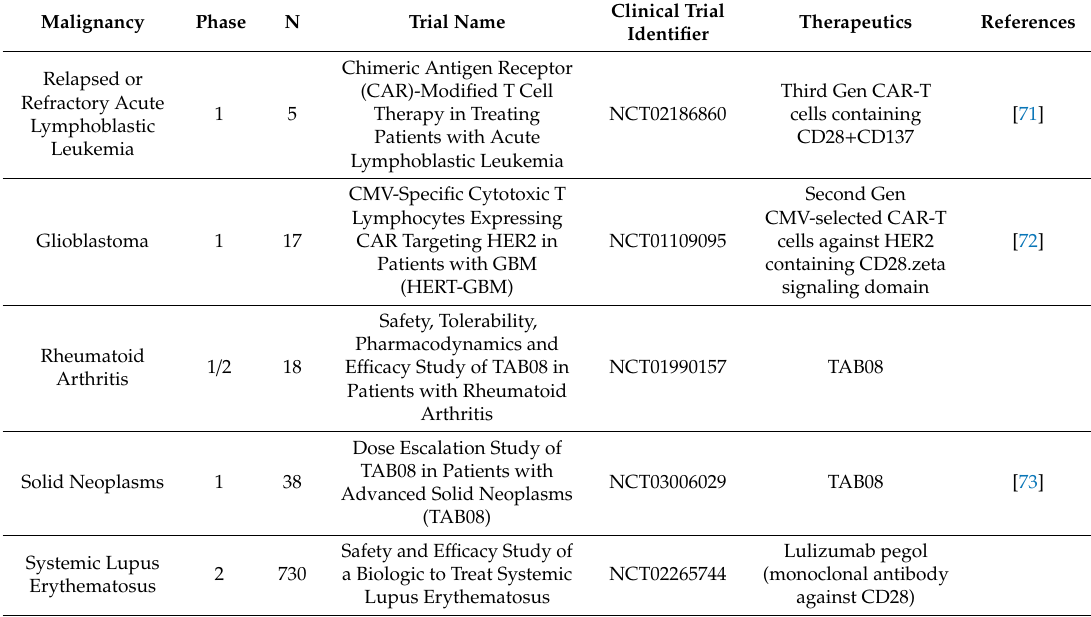
Table 1. Clinical trials related to the therapeutic use of CD28 manipulation, such as CAR-T cell therapy and monoclonal